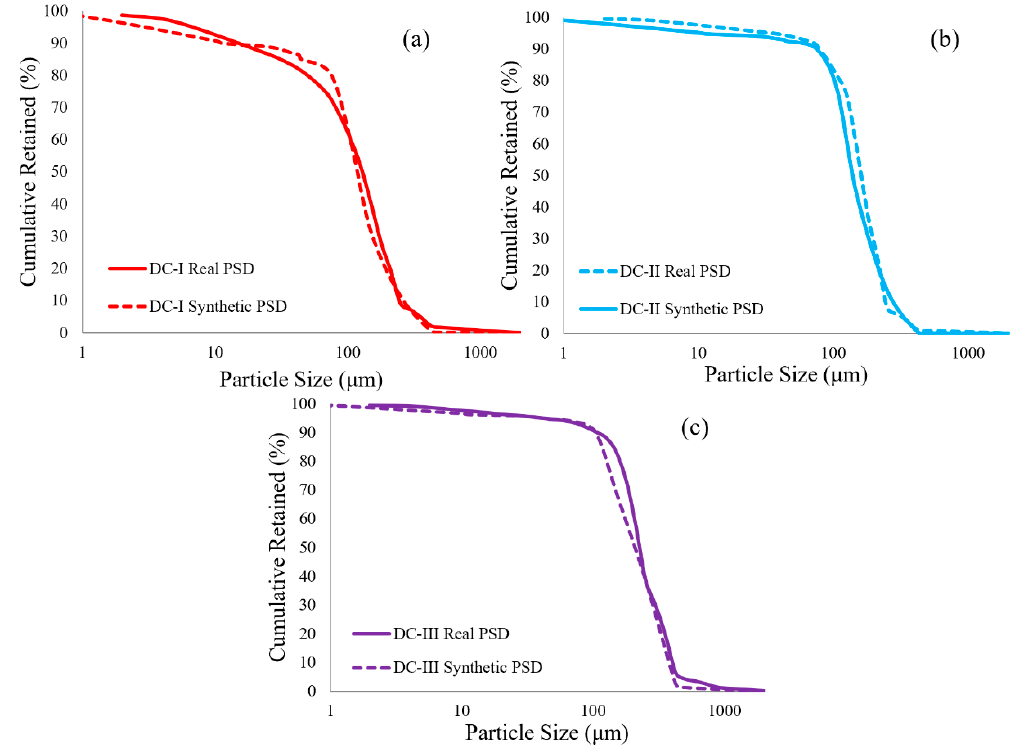
Figure 6. PSD replication of ( a ) DC-I, ( b ) DC-II and ( c ) DC-III.